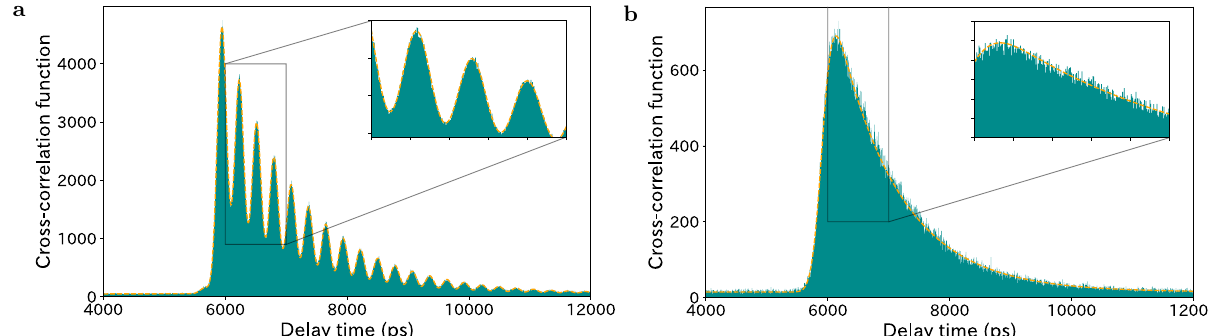
Figure 3. Temporal second-order cross-correlation. The delayed coincidence counts between the signal and idler photons with 4-ps time resolution, which correspond to the temporal second-order cross-correlation function. The polarizations are fixed in the horizontal direction, and the wavelengths of the signal and idler photons are 1580.48 nm and 1540.98 nm, respectively. The bandwidths of the BPFs are ( a ) 3.00 nm ( frequency mode) and ( b ) 0.03 nm (single-frequency mode). The data recording time is 1000 s. In ( a ), we observe the beating of coincidence counts, which is significant evidence of the quantum frequency comb.